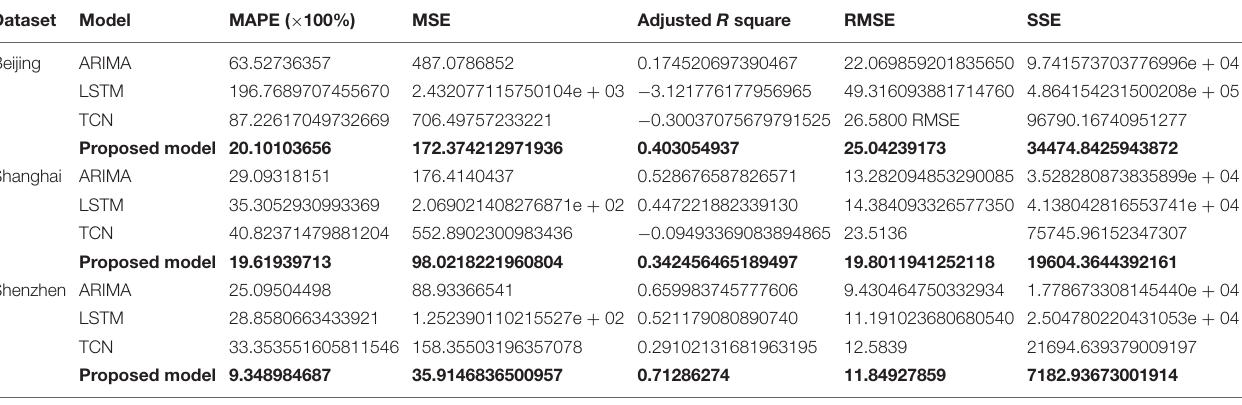
TABLE 6 | Statistical errors of the proposed system and three traditional models for daily PM 10 concentrations of Beijing, Shanghai, and Shenzhen. Dataset